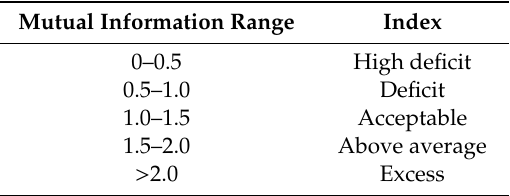
Table 3. Mutual information classification.